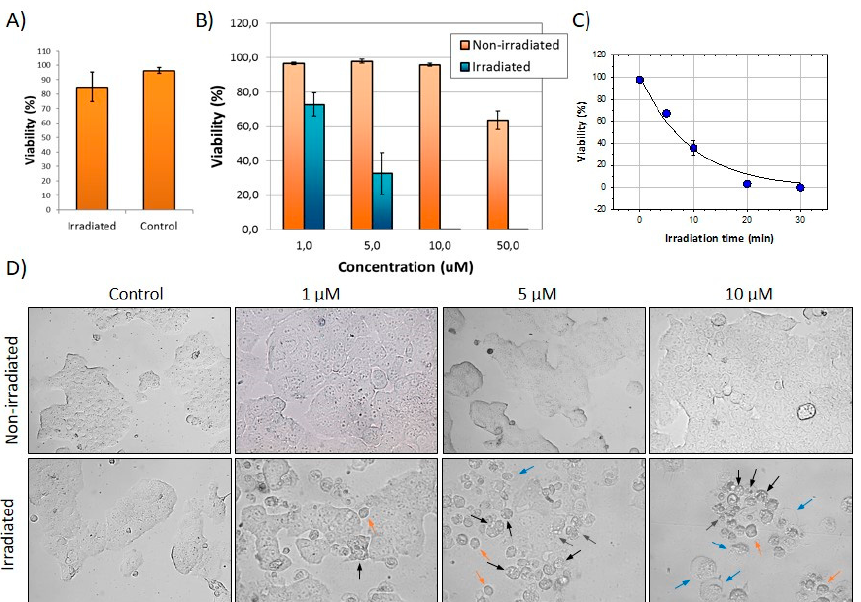
Figure 8. Photodynamic effects of FLTX2. ( A ) Effects of laser irradiation (475 nm) for 30 min on MCF-7 cells viability. ( B ) Concentration-dependence effects on MCF-7 cells viability irradiated for 30 min. ( C ) Effects of irradiation time on FLTX2-induced toxicity. ( D ) Phase contrast transmission representative images of irradiated and non-irradiated MCF-7 cells at different concentrations of FLTX2. Arrows indicate different apoptotic traits: intracellular vacuolation (black arrows), membrane blebbing (blue arrows), cell shrinkage (red arrows), cellular fragmentation (green arrows).